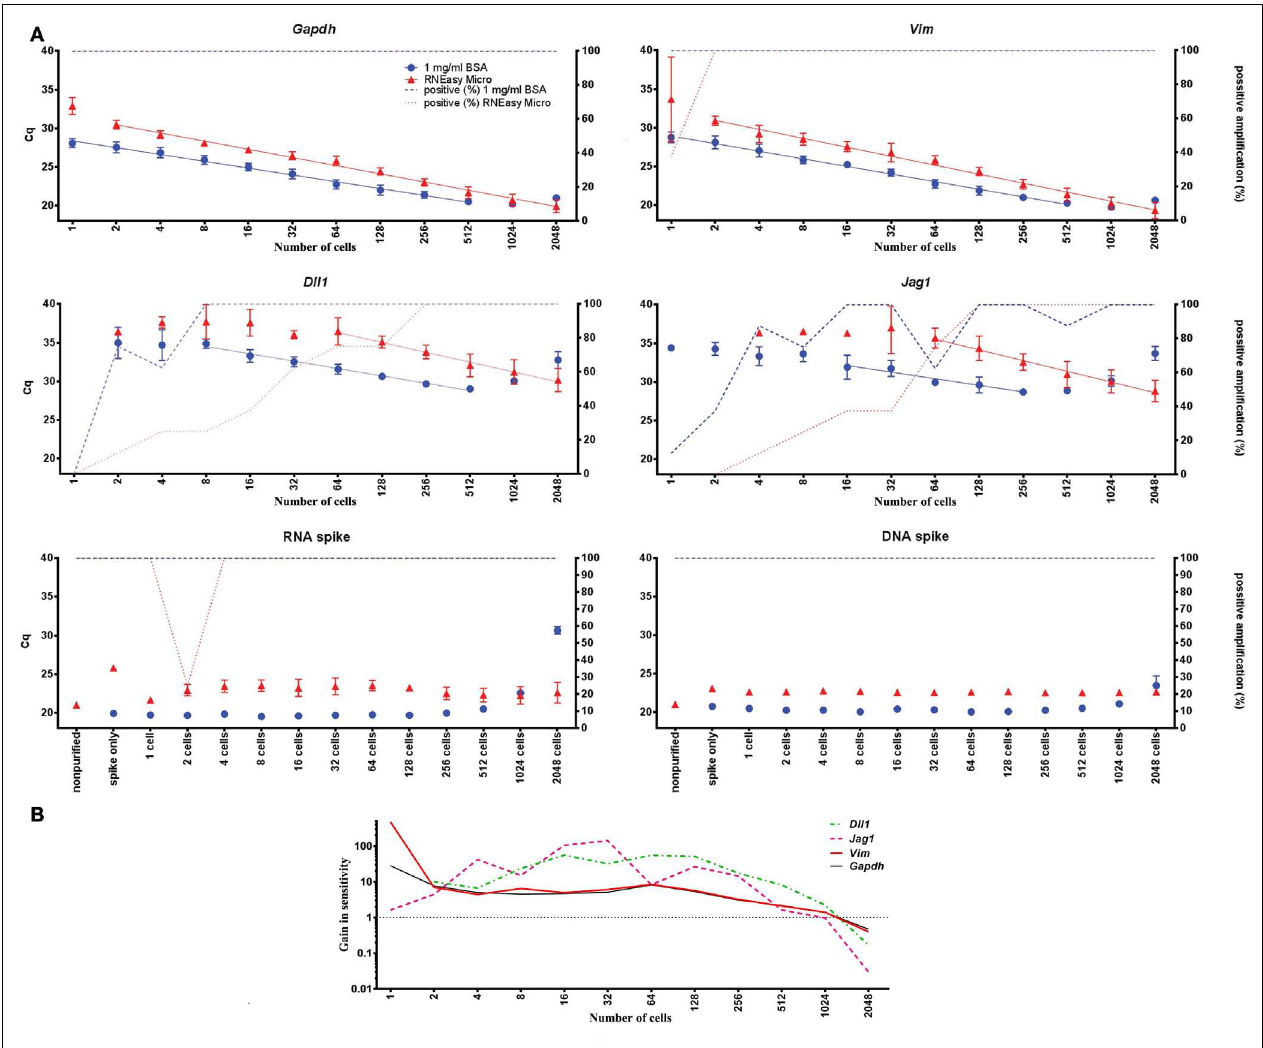
only” control sample shows the effect of column based extraction of the spikes alone without any cell material. Data are shown as mean ± SD ( n = 4) (see alsoTable S7 in Supplementary Material). (B) Comparison of direct cell lysis to column based extraction for all transcripts.The mean difference in sensitivity is shown by averaging the expression of Gapdh , Vim , Dll , and Jag1 .The dotted line, at a value of one, indicates when column based extraction is as efficient as direct lysis. Missing data were replaced with a Cq-value of